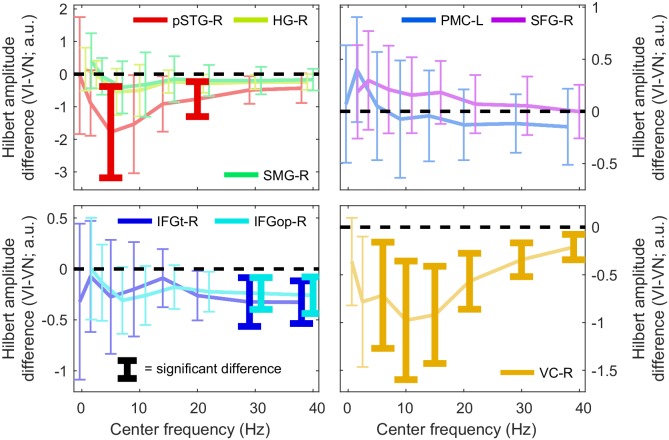
Condition-changes in the amplitude of oscillatory activity.Difference in the time-averaged Hilbert amplitude of the MEG signal between the VI and VN conditions for each ROI, as a function of frequency. Error bars bracket the 99% parametric confidence interval for the participant averaged difference. Thick bars highlight significant differences (FWE = 0.05 across ROIs and frequencies). a.u. = arbitrary units. Deposited data: SE_meg; AMP_amp.